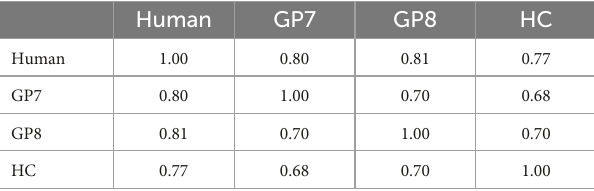
TABLE 1 Correlation analysis for comparison between different cameras and human labeling.